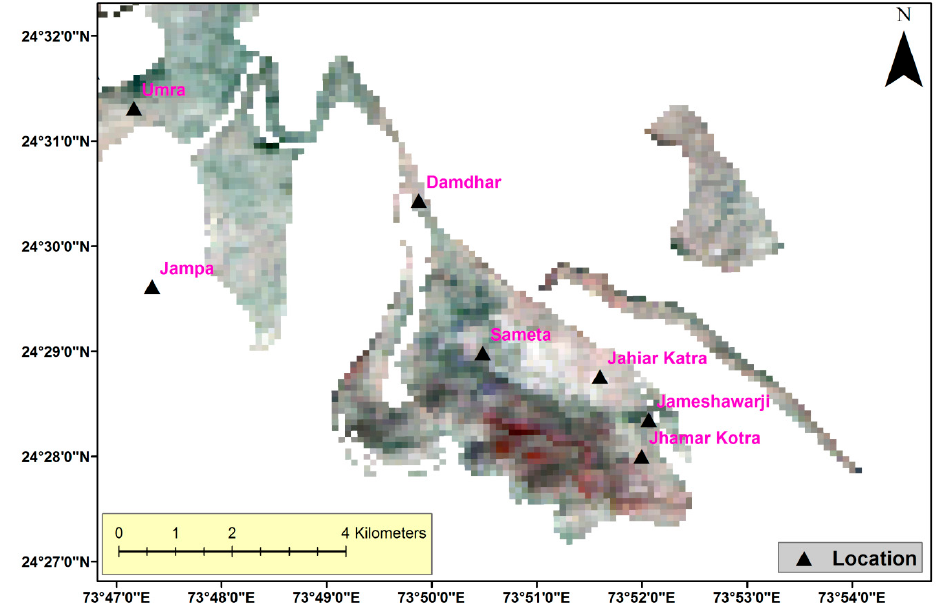
Figure 10. Decorrelation stretched false color composite prepared using spectral bands of ASTER level 1B radiance data. In this image composite, Red = Band 13, Green = band 12, and Blue = band 11 of ASTER thermal infrared sensor. Please refer to Table 1 for ASTER TIR band nuber